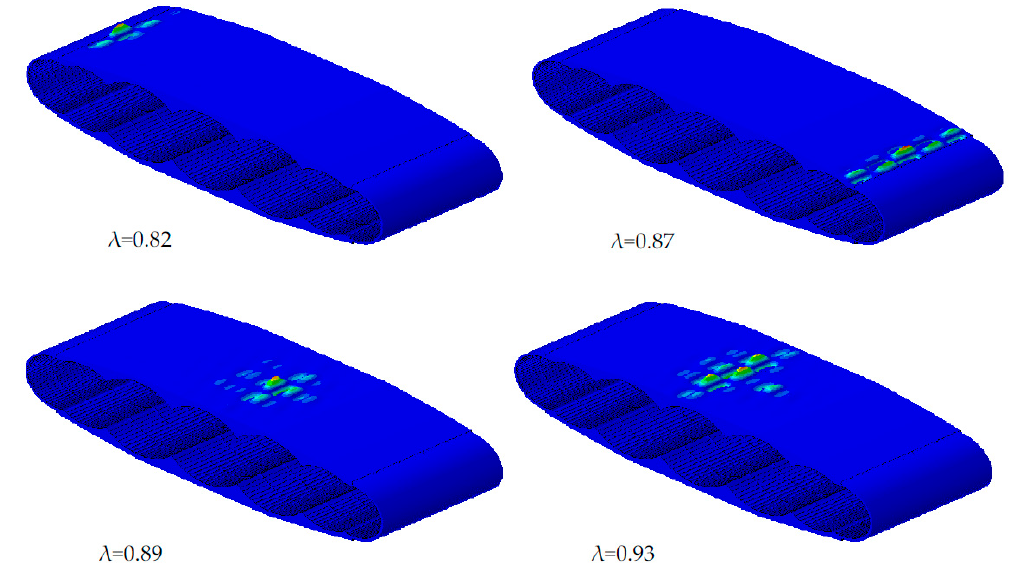
Figure 11. Four bucking modes of the linear buckling analysis for configuration 1 with five span-ribs, five frames.